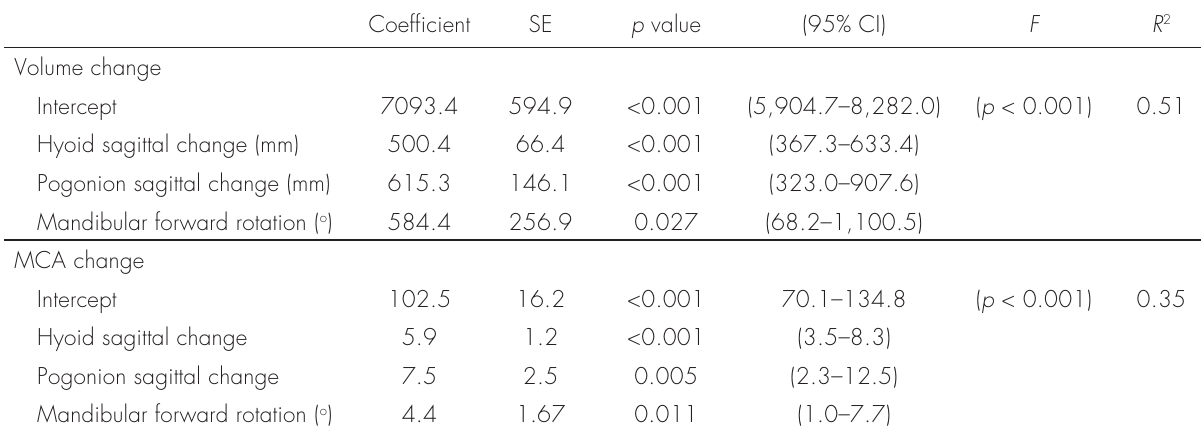
Table V. Stepwise backward linear regression model showing skeletal changes (structural method) with significant effects on changes in airway volume and MCA.